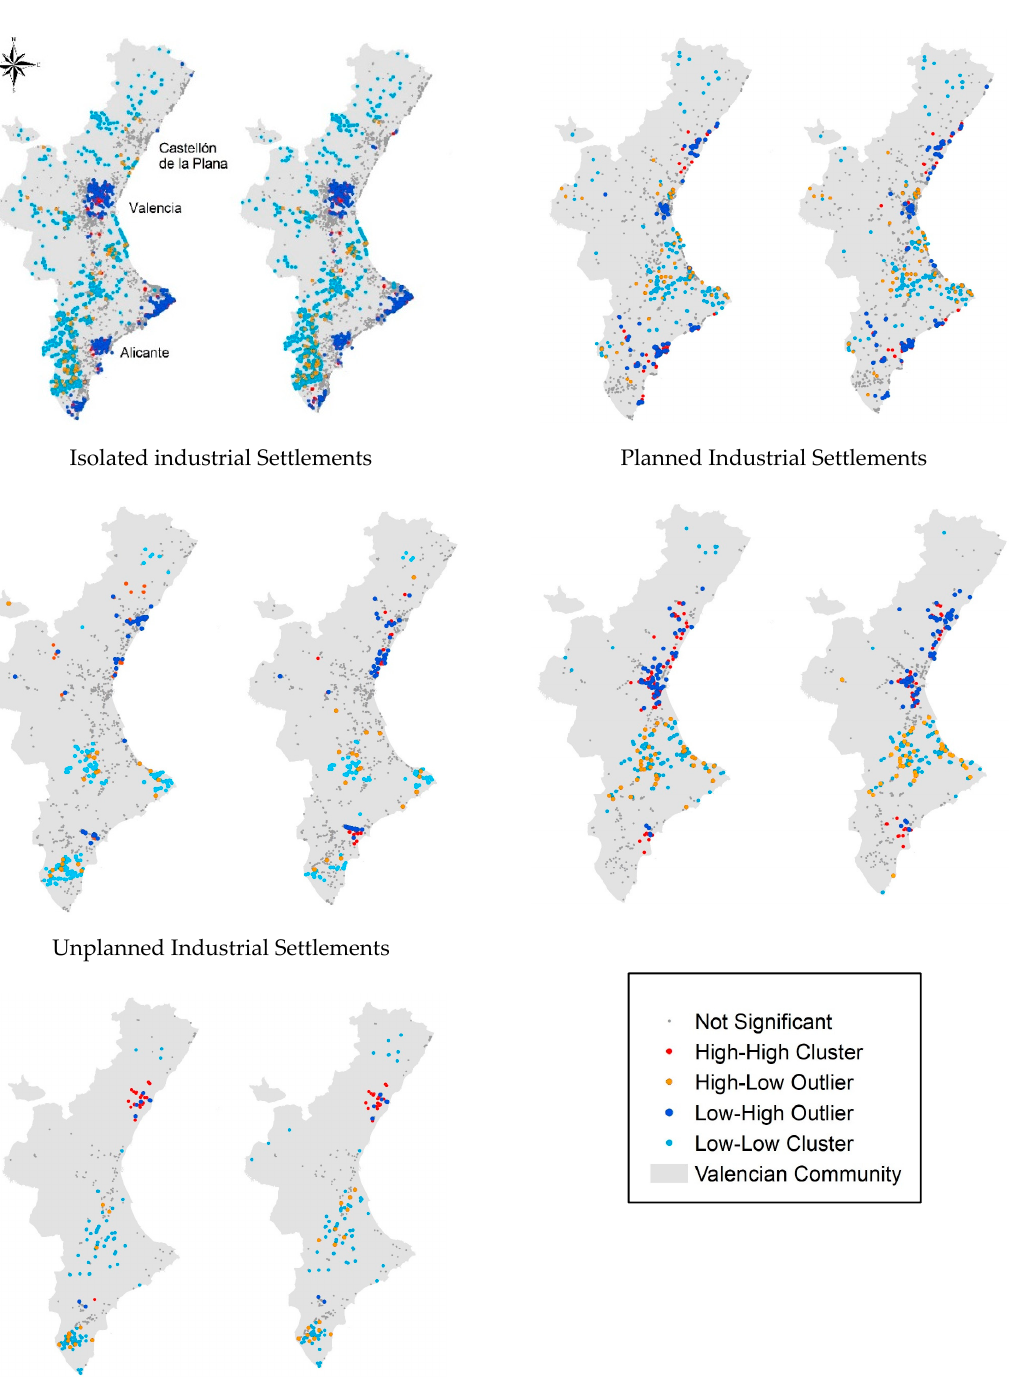
Figure 5. Results from a Moran’s spatial clustering by land-use type, 2005 and 2015.